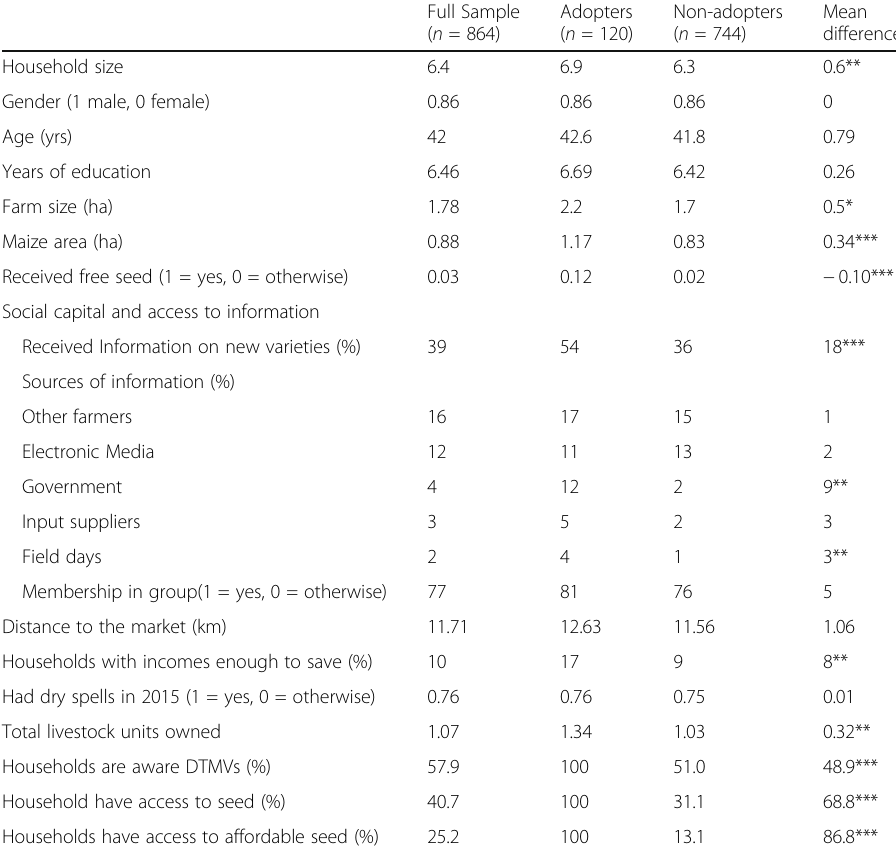
Table 1 Descriptive statistics by the adoption status of